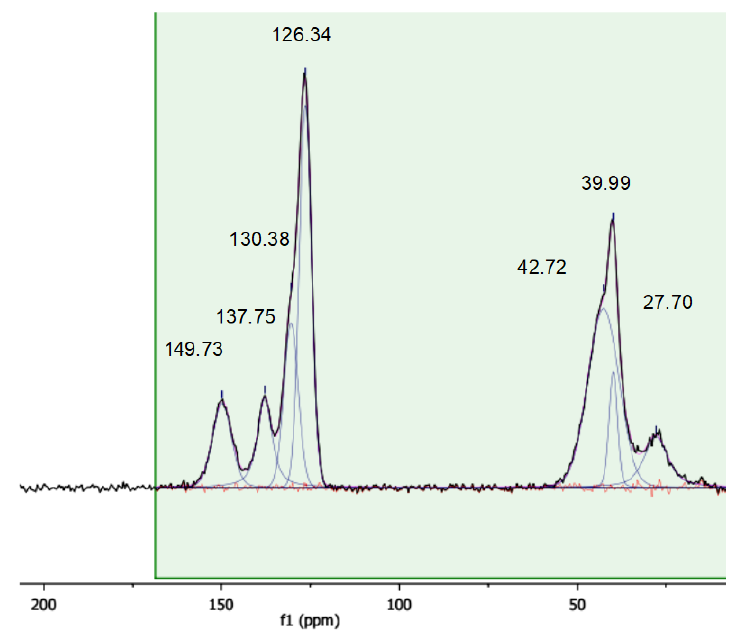
Figure 7. 1 H 13 C MAS spectrum of Gel_HClSO 3 . Contact time 1 ms, MAS rate 10 kHz, T = 25 ◦ C.